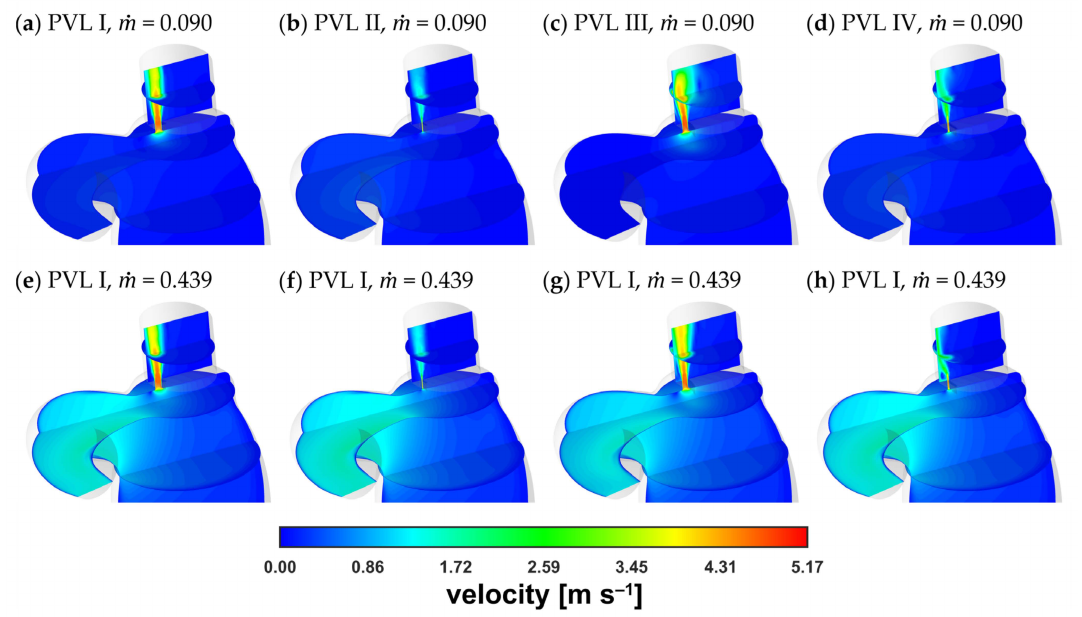
. m = 0.090 kg s − 1 ; ( e – h )